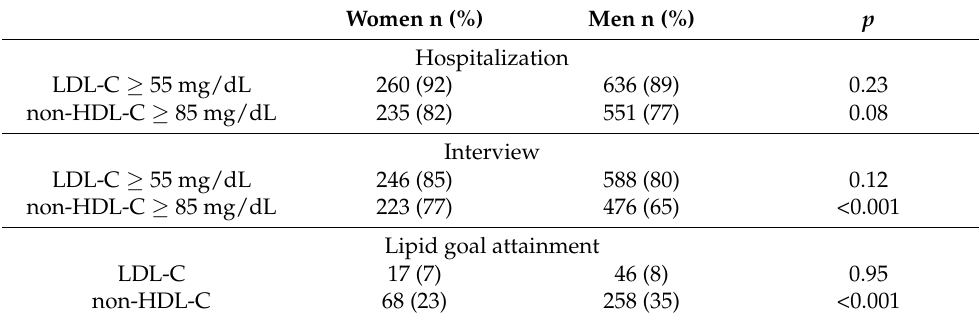
Table 5. LDL-C and non-HDL-C profiles and the lipid goals achievement according to 2019 ESC guidelines on